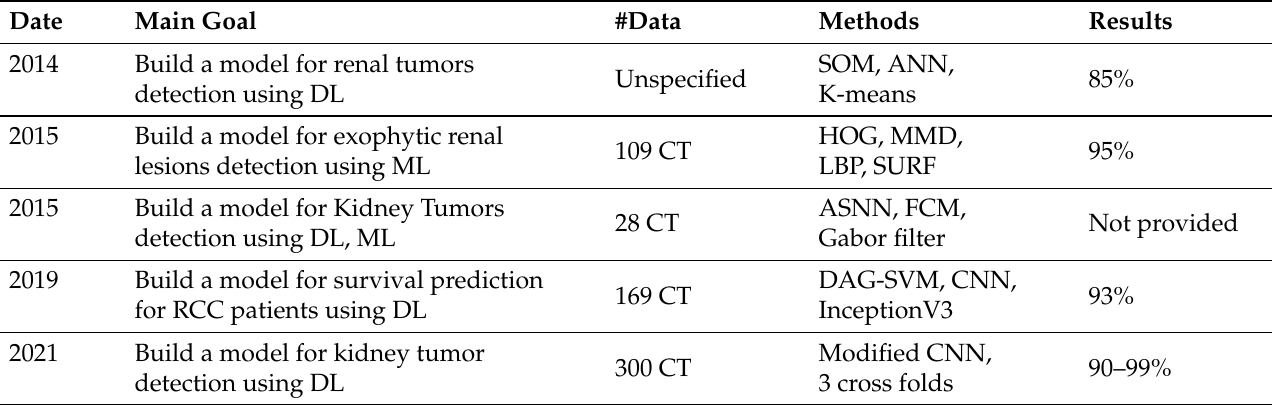
Table 3. The outcomes of the related detection tumor